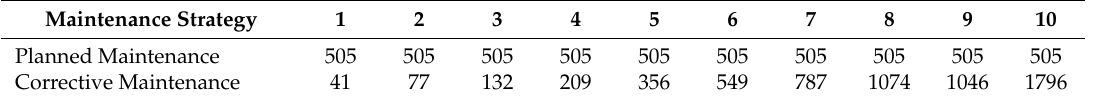
Table 12. Total hours allocated to both types of interventions (year 1 to year 10).